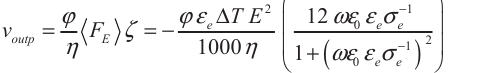
Fig. 13: Idealized time-averaged volume forces aqueous medium with a relative permittivity of 80 and a specific conductivity of 1.3 S/m over field frequency. The solid curve corresponds to finite-element simulations for the ETµP structures of Figures 11a and 13b obtained for an effective field- electrode voltage of 20 V PP over 390 µm field-electrode distance and a temperature difference across the electrode gap of approximately 5 K [Stubbe et al. 2013]. The dashed line presents the maximum force generated in a ETTWµP under the same conditions. The pump-peak frequency corresponds to the center frequency between the two ETµP